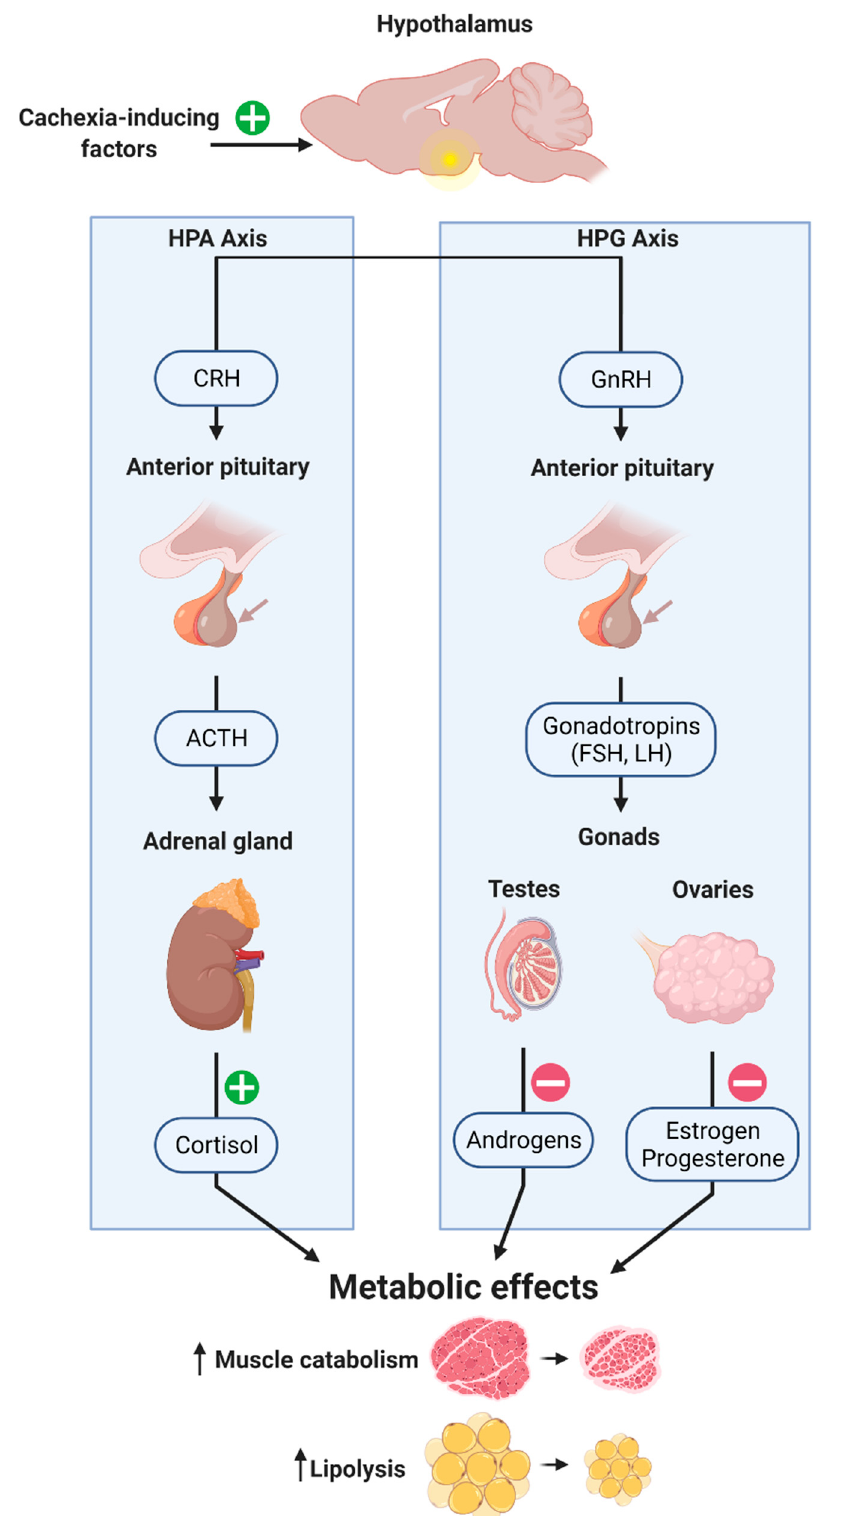
Figure 3. Model and potential mechanisms of hypothalamic–pituitary–adrenal/gonadal axes in the pathogenesis of cancer cachexia. pathogenesis of cancer